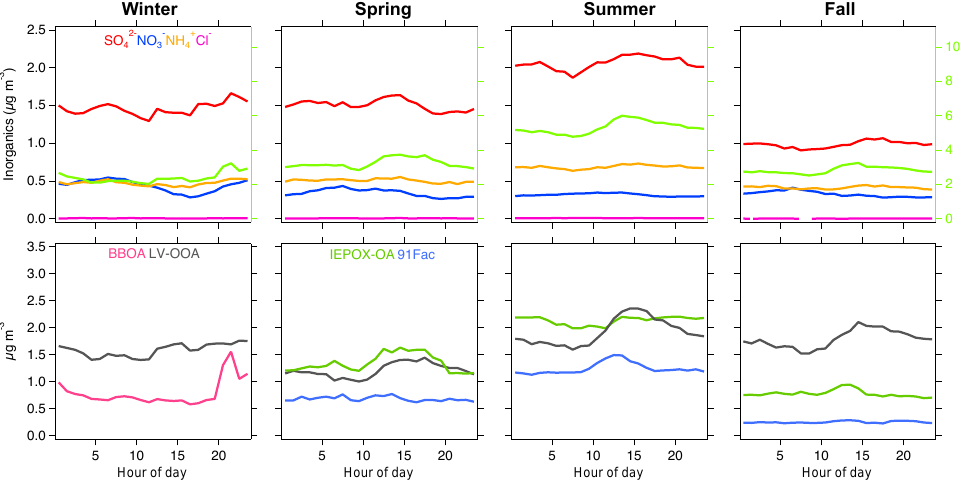
Figure 10. Diurnal variations of OA and inorganic species measured by ACSM (upper panel) and OA factors resolved by PMF analysis (lower panel) from winter, spring, summer and fall measurements at LRK in